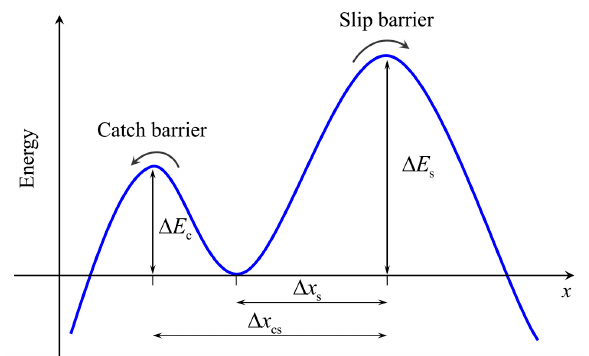
Figure 2. Schematic of conceptual energy landscape of two-pathway model [11,12]. A Brownian virtual particle can either escape over the catch barrier or over the slip barrier, starting from the bottom of the potential well.